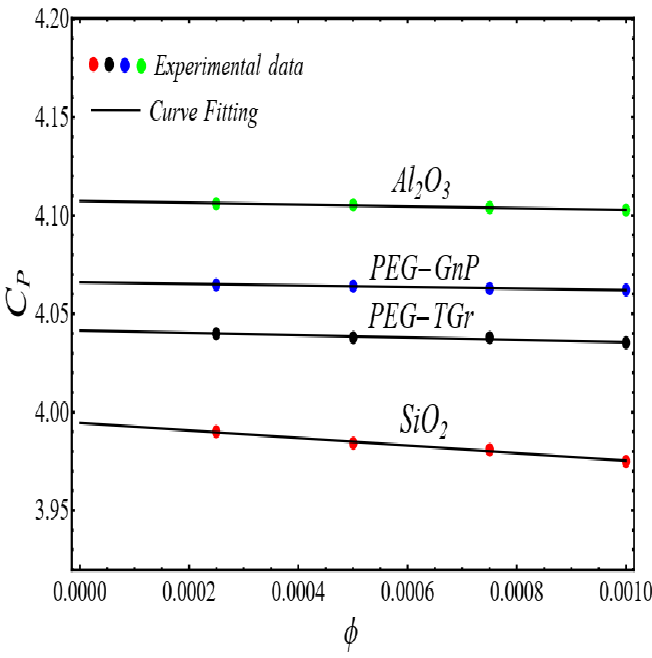
Figure 18. Fitting the Equation (5) for experimental data of schematic nanofluids.